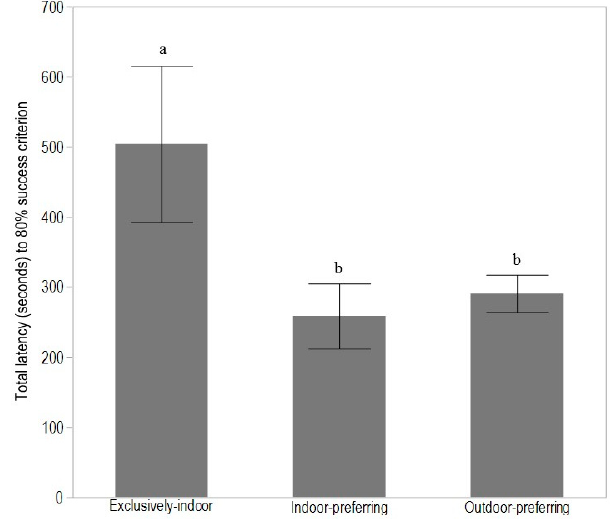
Figure 2. The mean ± SEM total latency (seconds) to minimum 80% success criterion during learning of the T-maze task for exclusively-indoor (range access on 0% of available days), indoor-preferring (range access on 2–10% of available days), and outdoor-preferring (range access on 100% of available days) adult hens. Different superscripts indicate significant differences across range access groups ( p < 0.05).